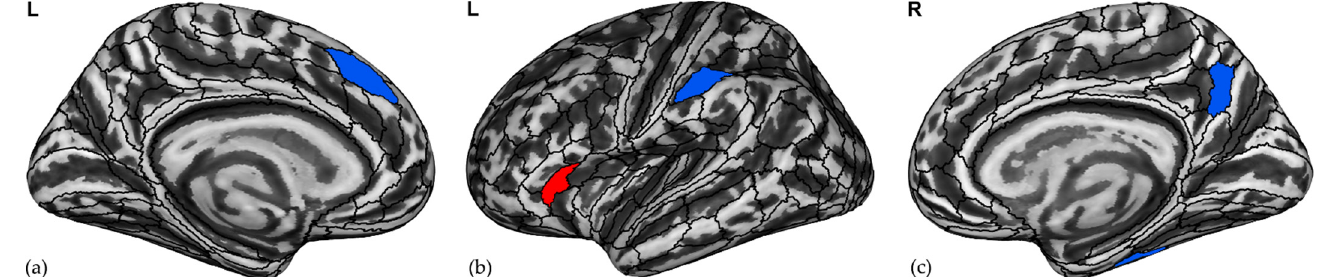
Figure 2. Increased (in red) cortical complexity in the ( b ) left frontal operculum OP5 (left FOP5) and a decrease (in blue) in ( a ) the left caudal part of the dorsomedial prefrontal cortex (8BM), ( b ) the left inferior parietal lobule with a thin cortical ribbon (PFt) and ( c ) the right 7 m and right temporal area F (TF), respectively, predict chess expertise using logistic regression. L, left; R, right.